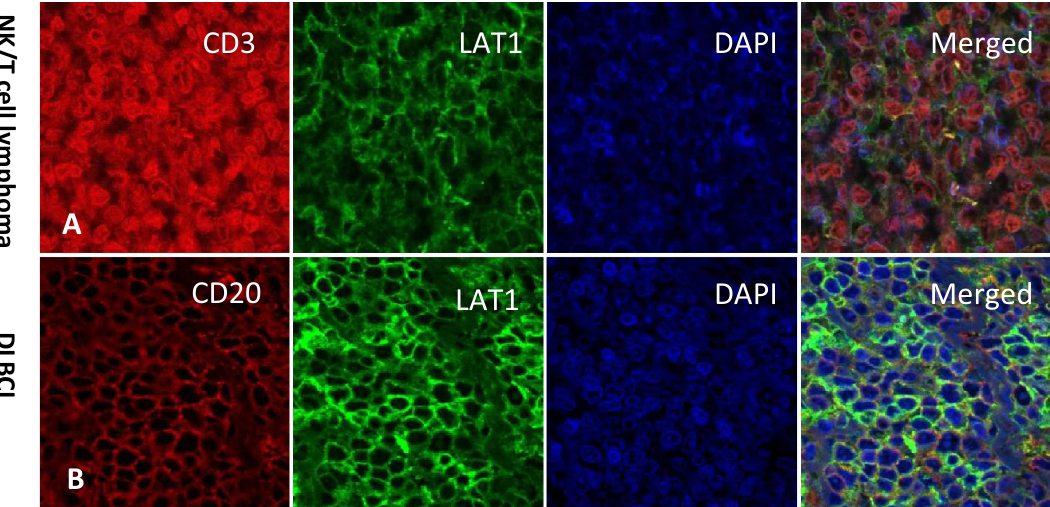
Figure 3. Representative images of immunofluorescence double staining of lymphoma cells with a T cell marker CD3 or a B cell marker CD20. ( A ) NK/T cell lymphoma cells co-expressed CD3 and LAT1. ( B ) DLBCL cells co-expressed CD20 and LAT1.